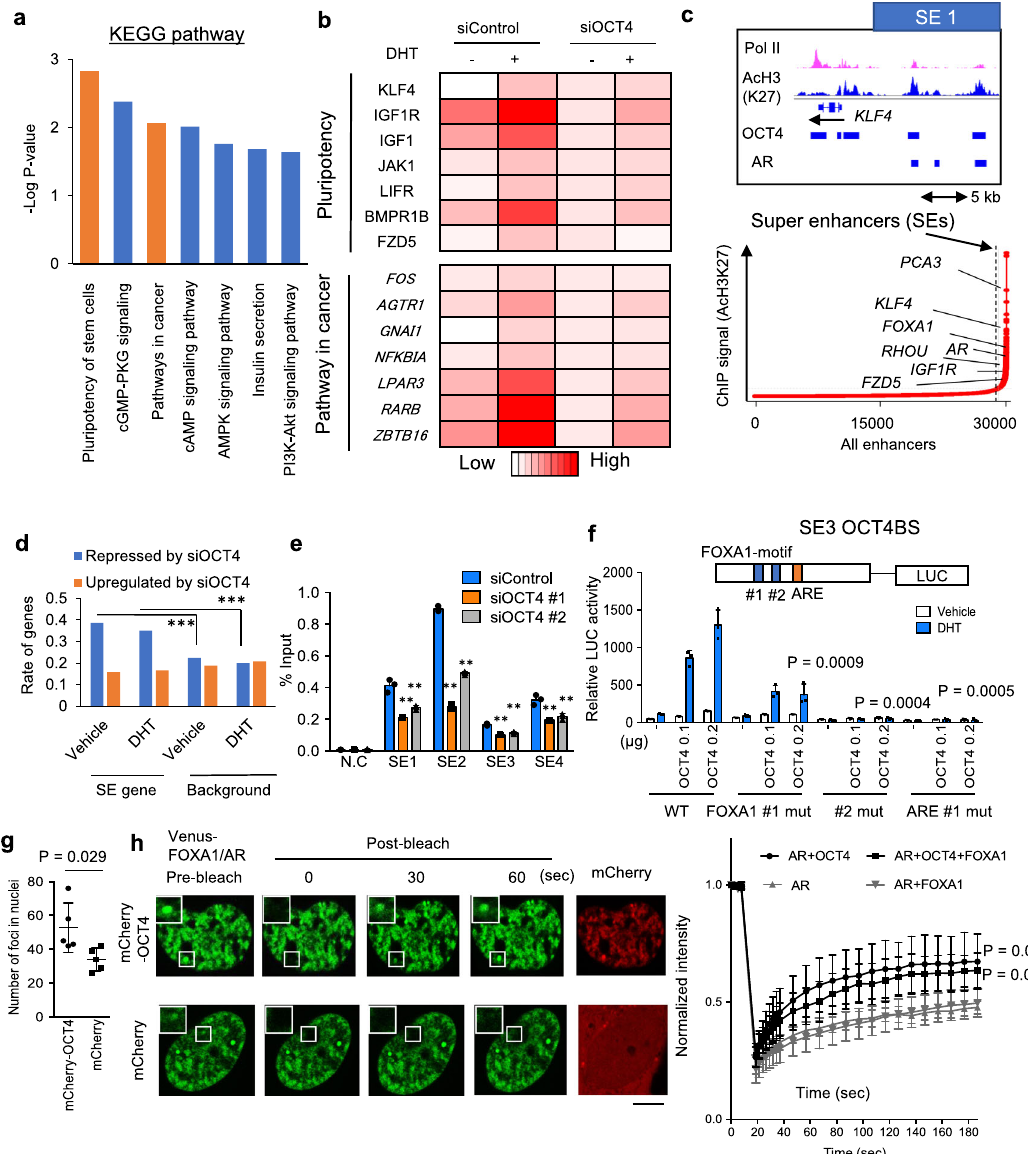
Fig. 3 The role of OCT4 in superenhancer (SE) establishments to facilitate AR transcription program. a KEGG-pathway analysis of AR/OCT4 target genes. AR- and OCT4-binding genes were closest genes to binding sites. We selected androgen-induced genes (>1.5 fold) repressed by siOCT4 #1 (fold < 0.7) by microarray. b Heatmap showing representative genes regulated by OCT4 and AR. c Identi fi cation of Superenhancers (SEs) in advanced PC cell model. ROSE analysis of AcH3K27 ChIP-seq signals in 22Rv1 cells. Representative genes in the vicinity of SEs are indicated. Signal tracks of SE signal (AcH3K27), RNA pol II reads on four representative SE genes. d Repressed (Fold < 0.5) or induced (Fold > 1.5) genes by OCT4 silencing in microarray data. Signi fi cant enrichment of repressed genes among SE genes were determined by two-sided chi-square test. *** P < 0.0001. e ChIP assay of AcH3K27 was performed ( N = 3, technical replicates). 22Rv1 cells were treated with siControl, siOCT4 #1, or #2 for 48 h. ** P < 0.01. two-sided t -test was used to compare siOCT4 with siControl. Data are presented as average ± S.D. f (Upper) Luciferase vectors (wild type or mutation of FOXA1 motif #1, #2 or ARE) were constructed by inserting OCT4-binding sequence to pGL3-promoter vector. (Lower) LNCaP cells were transfected with luciferase vectors complexed with HA-OCT4 or control vector. Cells were then treated with DHT or vehicle for 24 h and luciferase assay was performed ( N = 3, biological replicates). Two-sided t -test was performed to compare with WT. Data are presented as average ± S.D. g Venus-FOXA1 and Venus-AR were co-transfected with mCherry or mCherry-OCT4 into 293T cells. The number of nuclear foci is counted and quanti fi ed ( N = 5, biological independent cells). Two-sided t -test was performed. Data are presented as average ± S.D. h FRAP kinetic plots and representative images from pre- and post-bleaching cells ( N = 4, biological independent cells). 293T cells were transfected with (1) Venus-FOXA1, Venus-AR, and mCherry-OCT4 (AR + FOXA1 + OCT4), (2) Venus-AR and mCherry-OCT4 (AR + OCT4), (3) Venus-FOXA1, Venus-AR and mCherry (AR + FOXA1), or (4) Venus-AR and mCherry (AR). Representative images of (1) and (3) are shown. Cells were treated with DHT for 2 h. Bar = 10 μ m. Two-sided t -test was performed. Data are presented as average ± S.D. Source data are provided as a Source Data fi